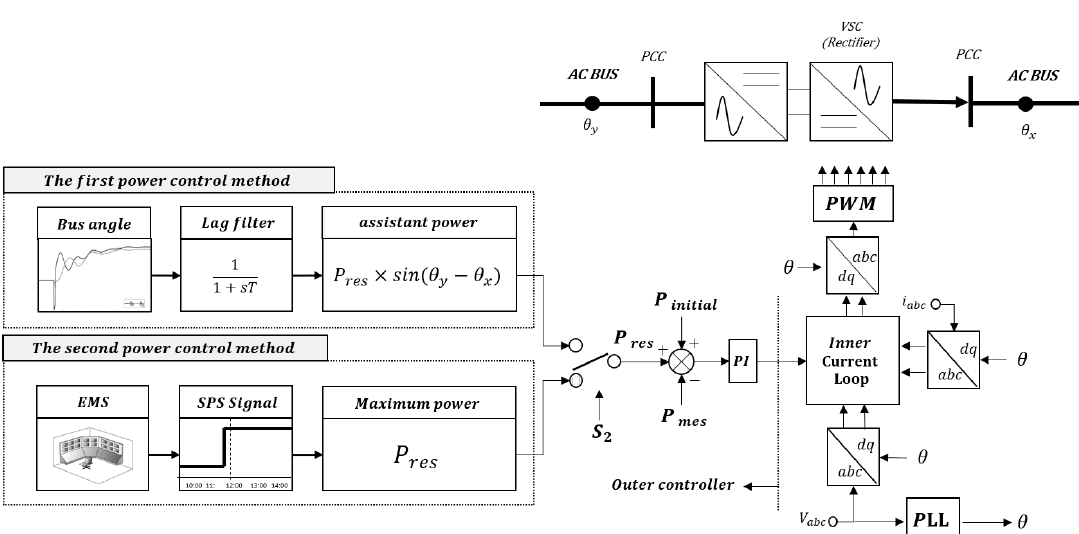
Figure 5. The second power control model of BTB VSC.